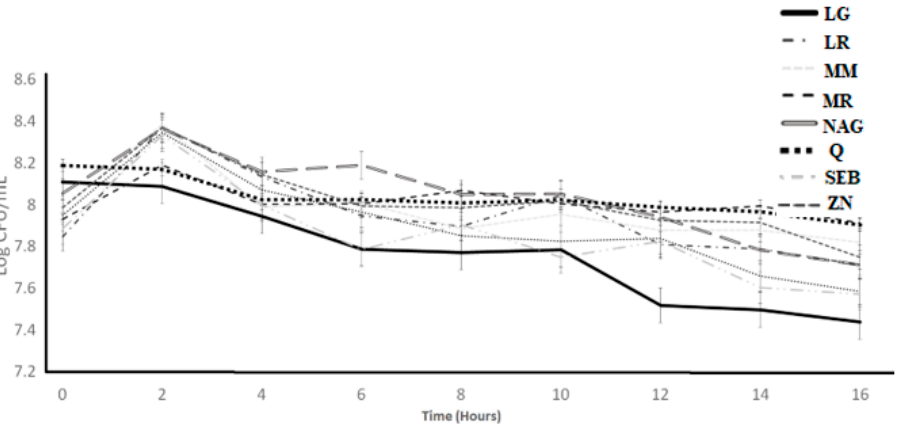
Figure 6. Log counts of Lactobacillus bulgaricus showing its growth as in fl uenced by ingredients over the incubation period of 16 h. C = control, LG = L-glutamine (7 g/L), Q = quercetin (700 mg/L), SEB = slippery elm bark (210 mg/L), MR = marshmallow root (1340 mg/L), NAG = N-acetyl-D-glucosamine (210 mg/L), LR = licorice root (210 mg/L), MM = maitake mushrooms (42 mg/L), and ZN = zinc orotate (70 mg/L). Error bars represent SE.